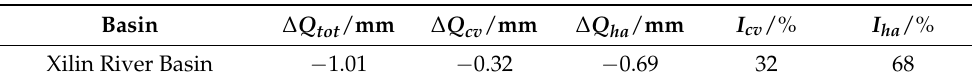
Table 6. Effects of climate change and human activities on runoff reduction over the Xilin River Basin in the period of 1998–2019.